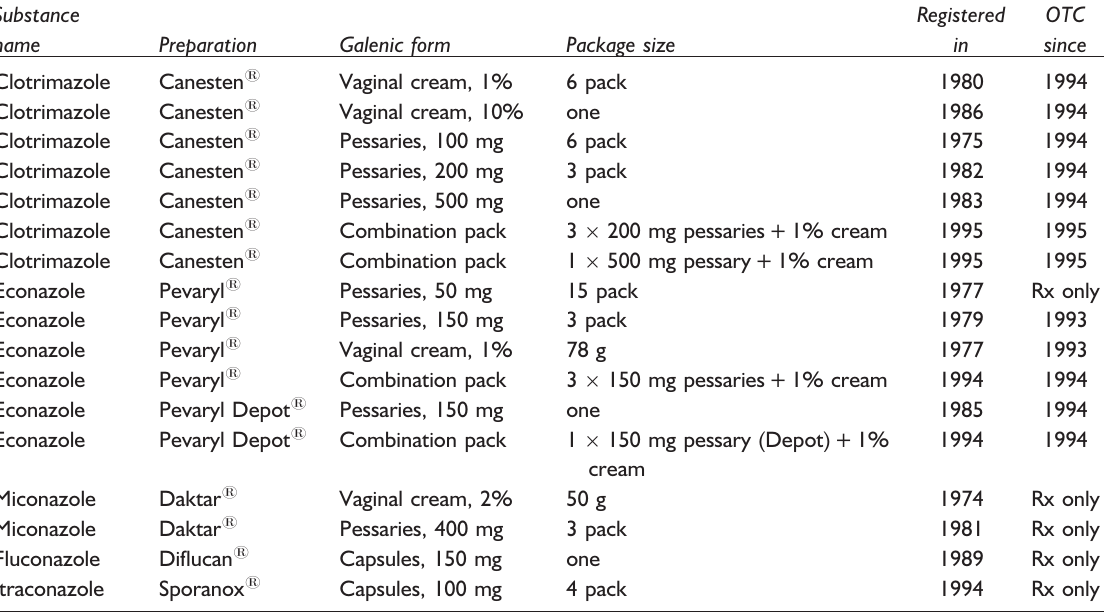
Table 1 Drugs available for therapy of vaginal Candida infections in Sweden during the